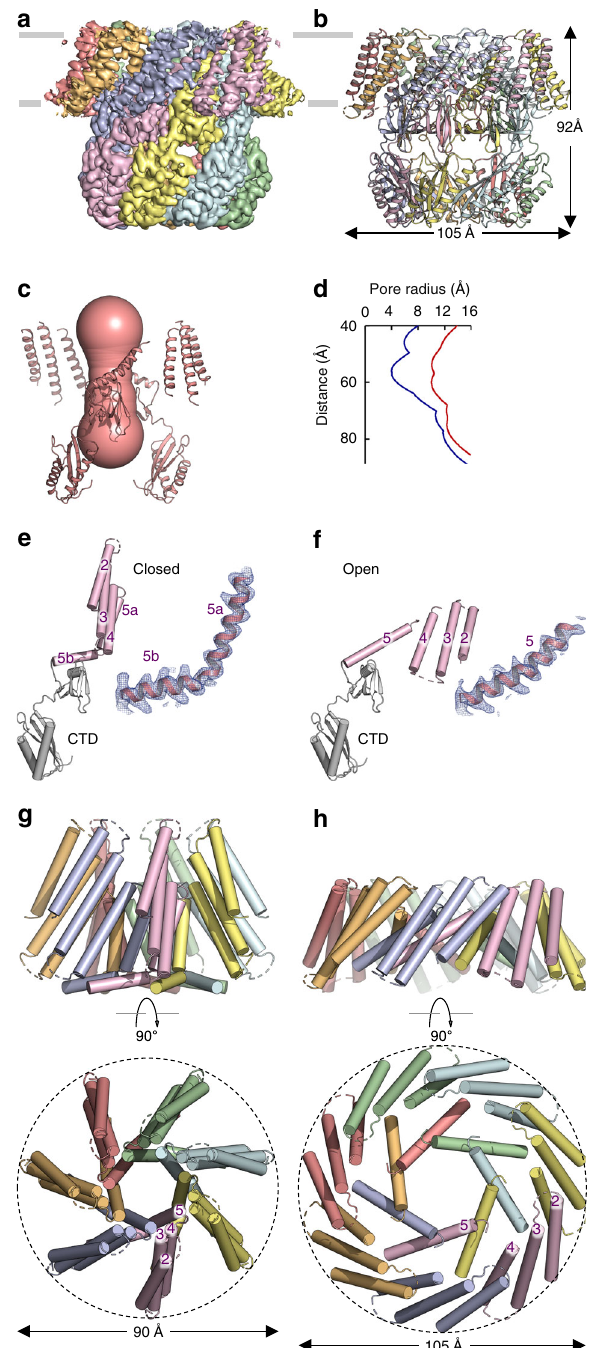
Fig. 4 Structure of A320V and channel opening. a Cryo-EM density, contoured at 5.0 σ , for the A320V mutant. Each subunit is in a unique color. b Structure of A320V. The dimension of the channel is indicated. c The wide-open pore of A320V. d The pore pro fi les of the closed wild type (blue) and the open A320V mutant (red). e , f Structures of a single subunit for the wild type ( e ) and the A320V mutant channels ( f ). The C- terminal extramembrane domain in the mitochondrial matrix is colored in gray and the transmembrane region is colored in magenta. Cryo-EM densities, contoured at 7.0 σ , are shown for TM5. g , h Orthogonal views of the transmembrane domains of the wild-type MSL1 ( g ) and the A320V mutant ( h